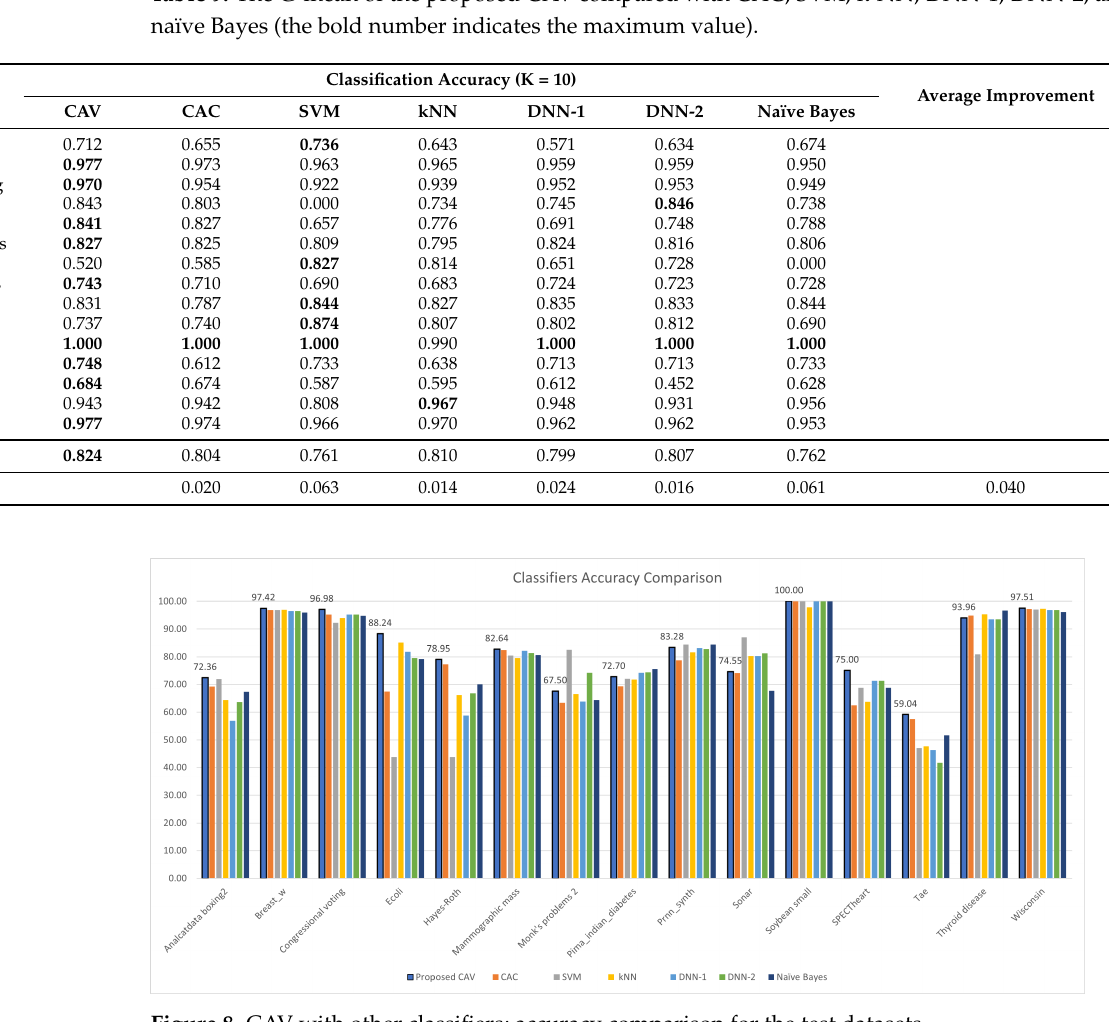
Figure 8. CAV with other classifiers; accuracy comparison for the test